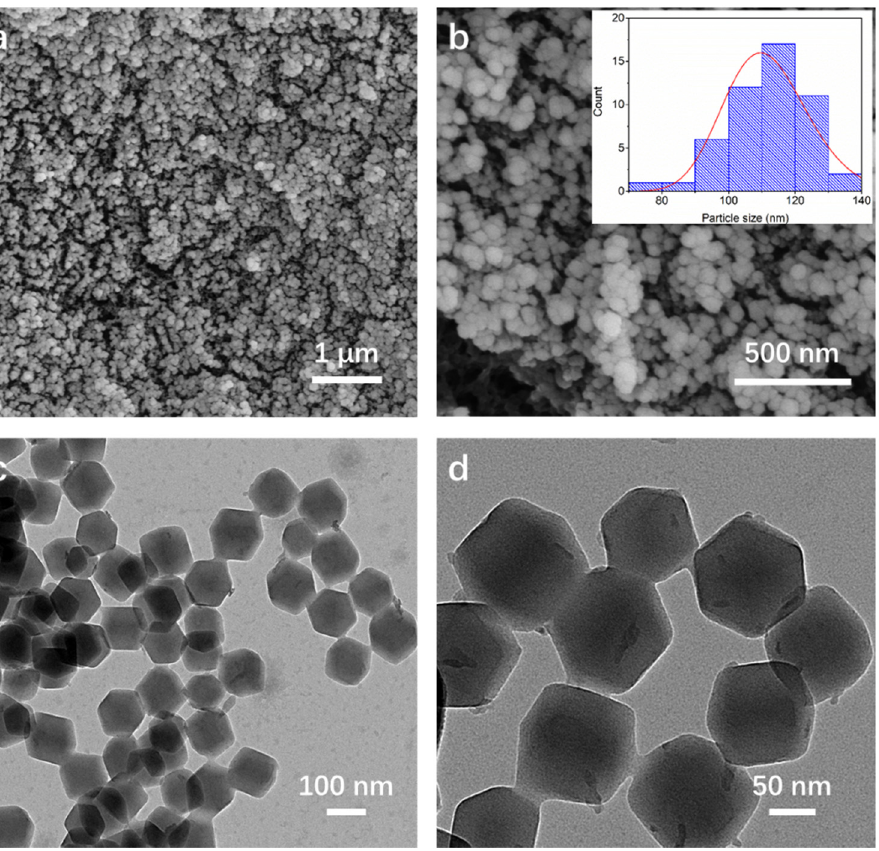
Figure 2: ( a and b ) SEM images and ( c and d ) TEM images of ZIF - 8 nanomaterials under di ff erent magni fi cations. Inset shows the size